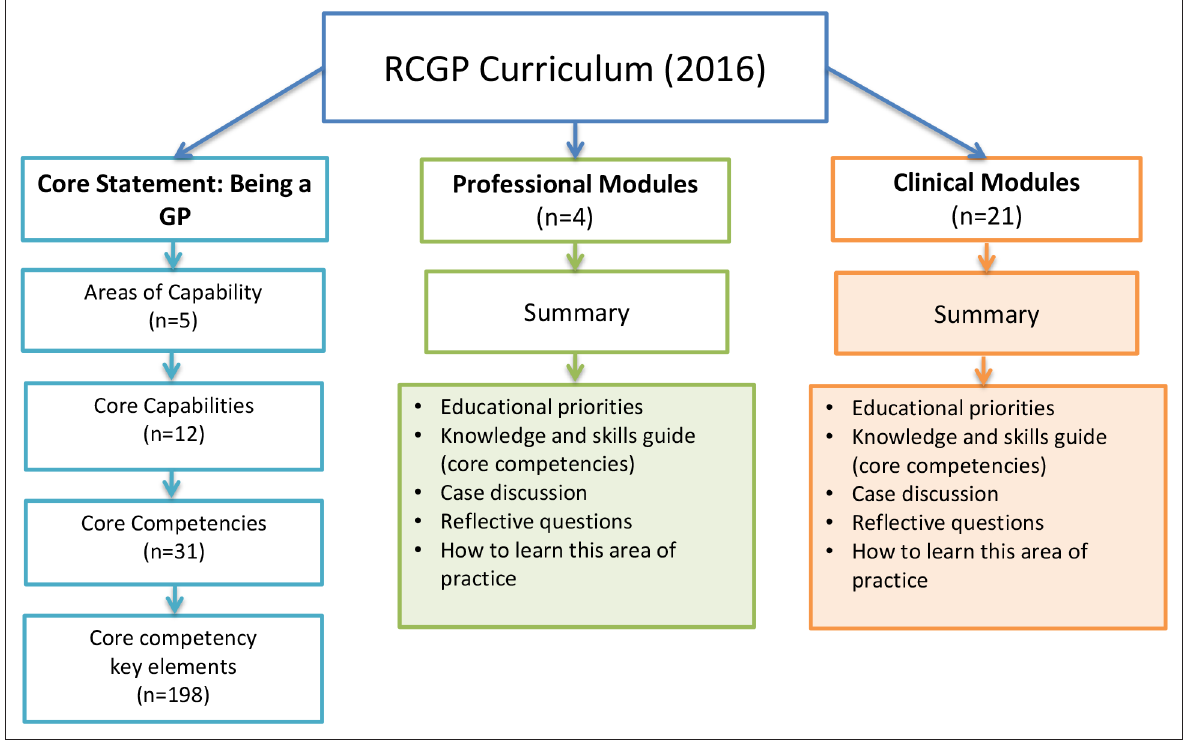
Figure 4 Structure and overview of content of the RCGP 2016 curriculum n represents the number of items within each section of the curriculum. Mapping was undertaken at the level of the unshaded boxes